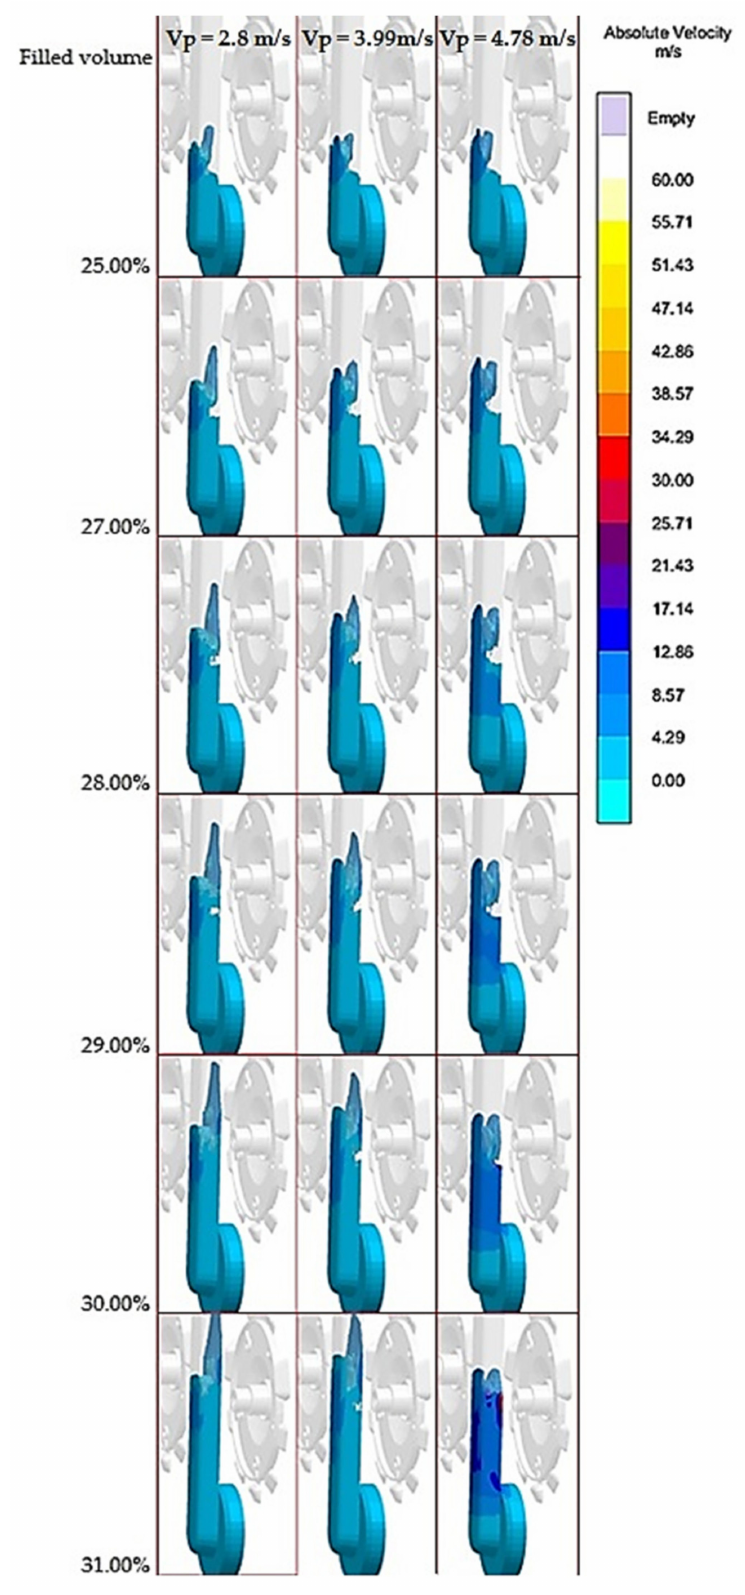
Figure 5. Gas entrapment by the melt in the runner in the area of measurement points of